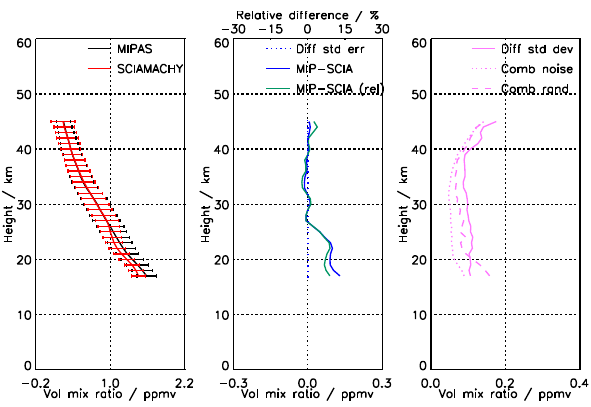
Figure 4. Comparison between volume mixing ratios of CH 4 from GCASN and MIPAS reduced resolution (V5R_CH4_225 and V5R_CH4_224). Large black circles/continuous line: monthly mean mixing ratios for MIPAS, small black circles/dashed line: standard deviation for MIPAS; red continuous line: monthly mean mixing ratios for GCASN; red dashed line: standard deviation for